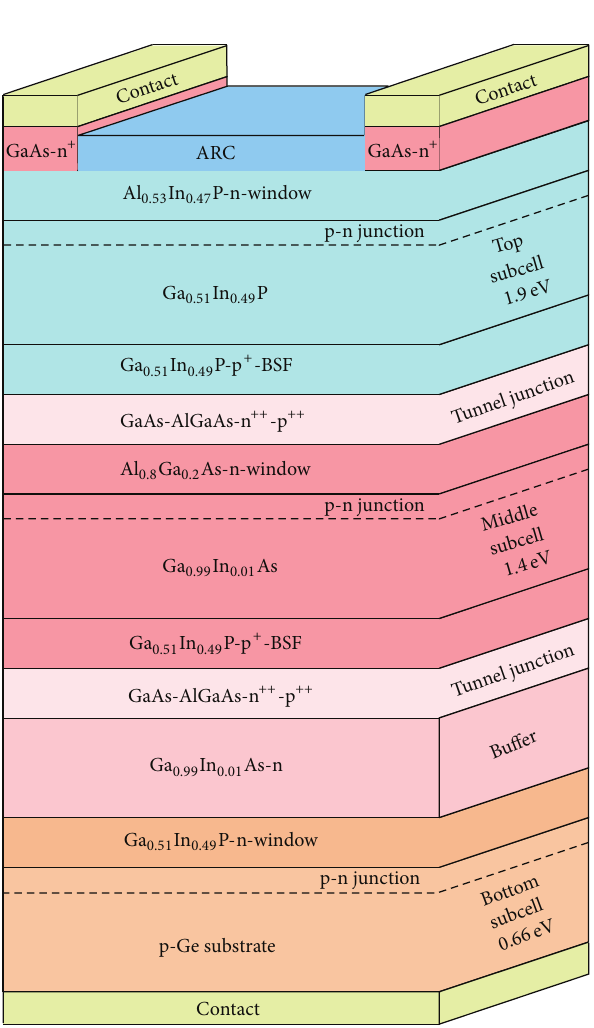
Figure 1: Schematic structure of a GaInP/GaInAs/Ge triple-junc- tion solar